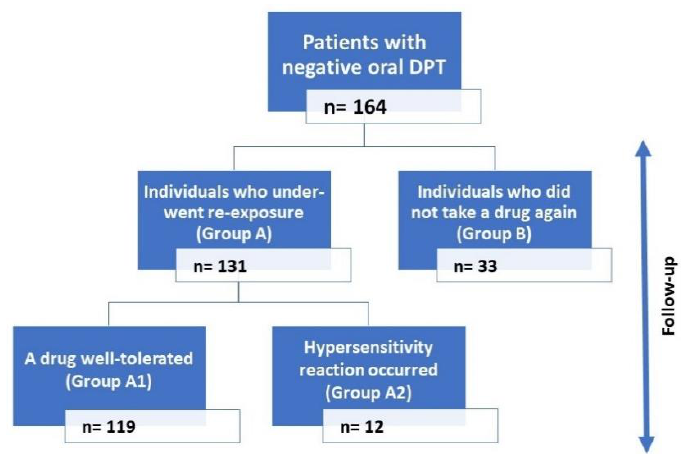
Figure 1. The results of the follow-up interview regarding reexposure to the drugs.